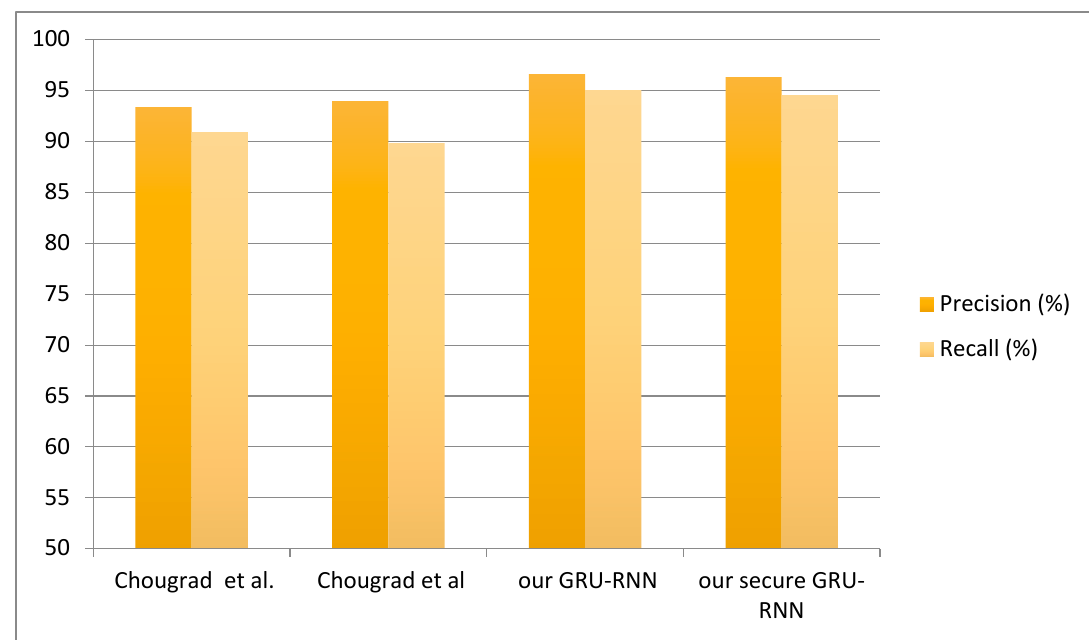
Figure 7. Performance comparison for the HDD dataset.